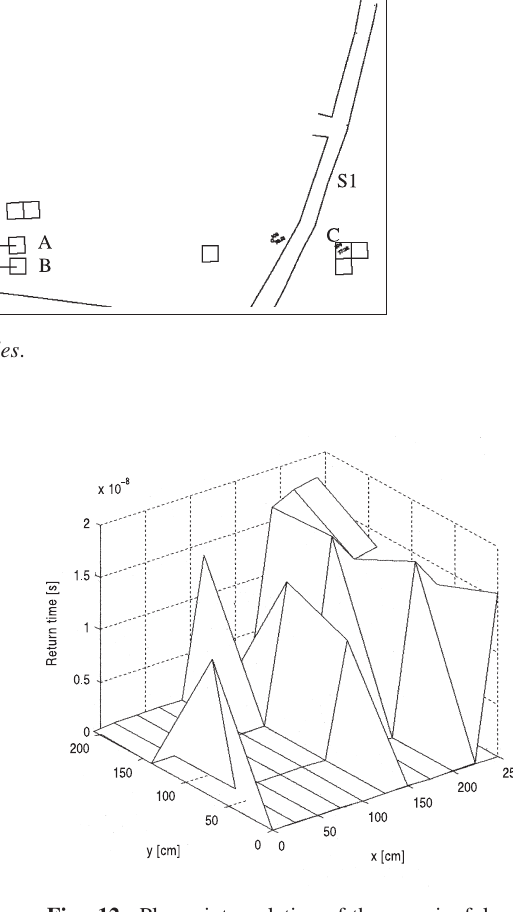
Fig. 12. Planar interpolation of the meaningful re- turn times on the Roman road (square